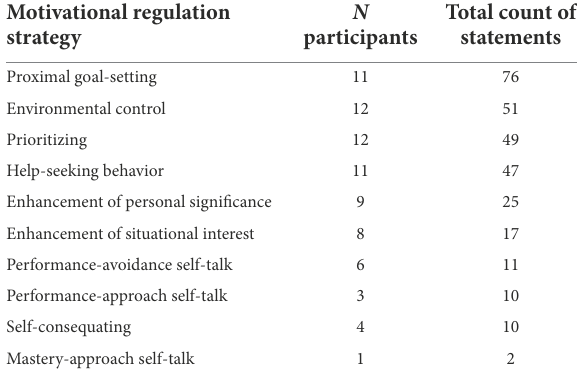
TABLE 1 Motivational regulation